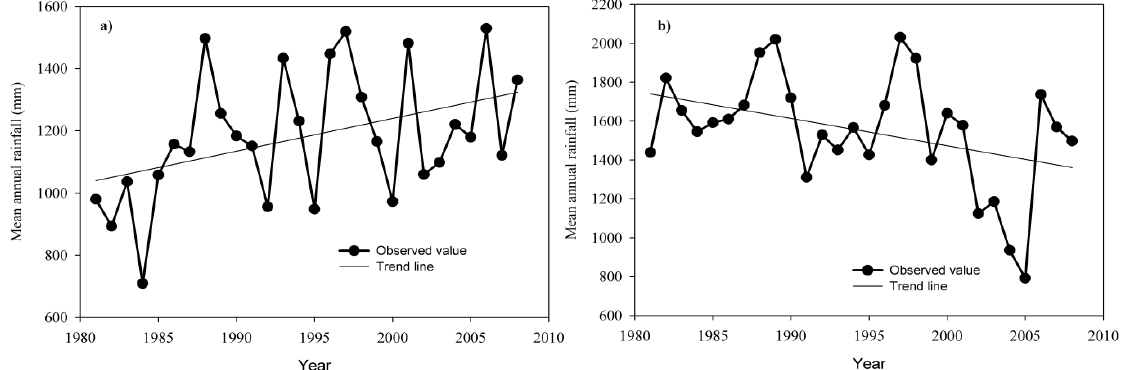
Figure 4. The mean annual rainfall trends for selected stations using a Mann-Kendall test: ( a ) Assendabo station and ( b ) Shebe station.